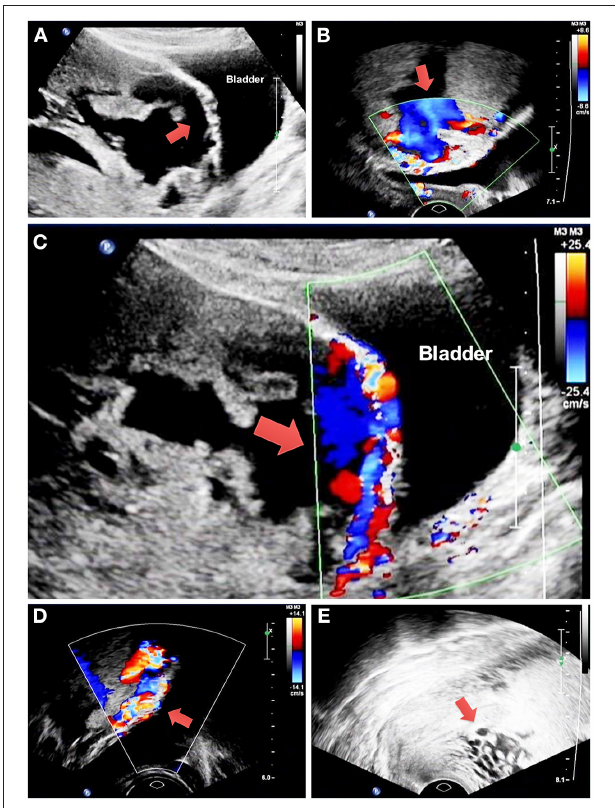
FIGURE 2 | Doppler findings in patients with severe placenta accreta spectrum with previa. (A) The red arrow shows retroplacental myometrial thickness < 1mm and irregularity of the uterine-bladder interface. (B) The red arrow shows intraplacental vascular lacunae. (C) The red arrow shows hypervascularity of the uterine-placental margin and uterine serosa-bladder wall interface. (D) The red arrow shows hypervascularity of the uterine serosa-bladder wall interface. (E) The red arrow shows cervical hypervascularity. PAS, placenta accreta spectrum.